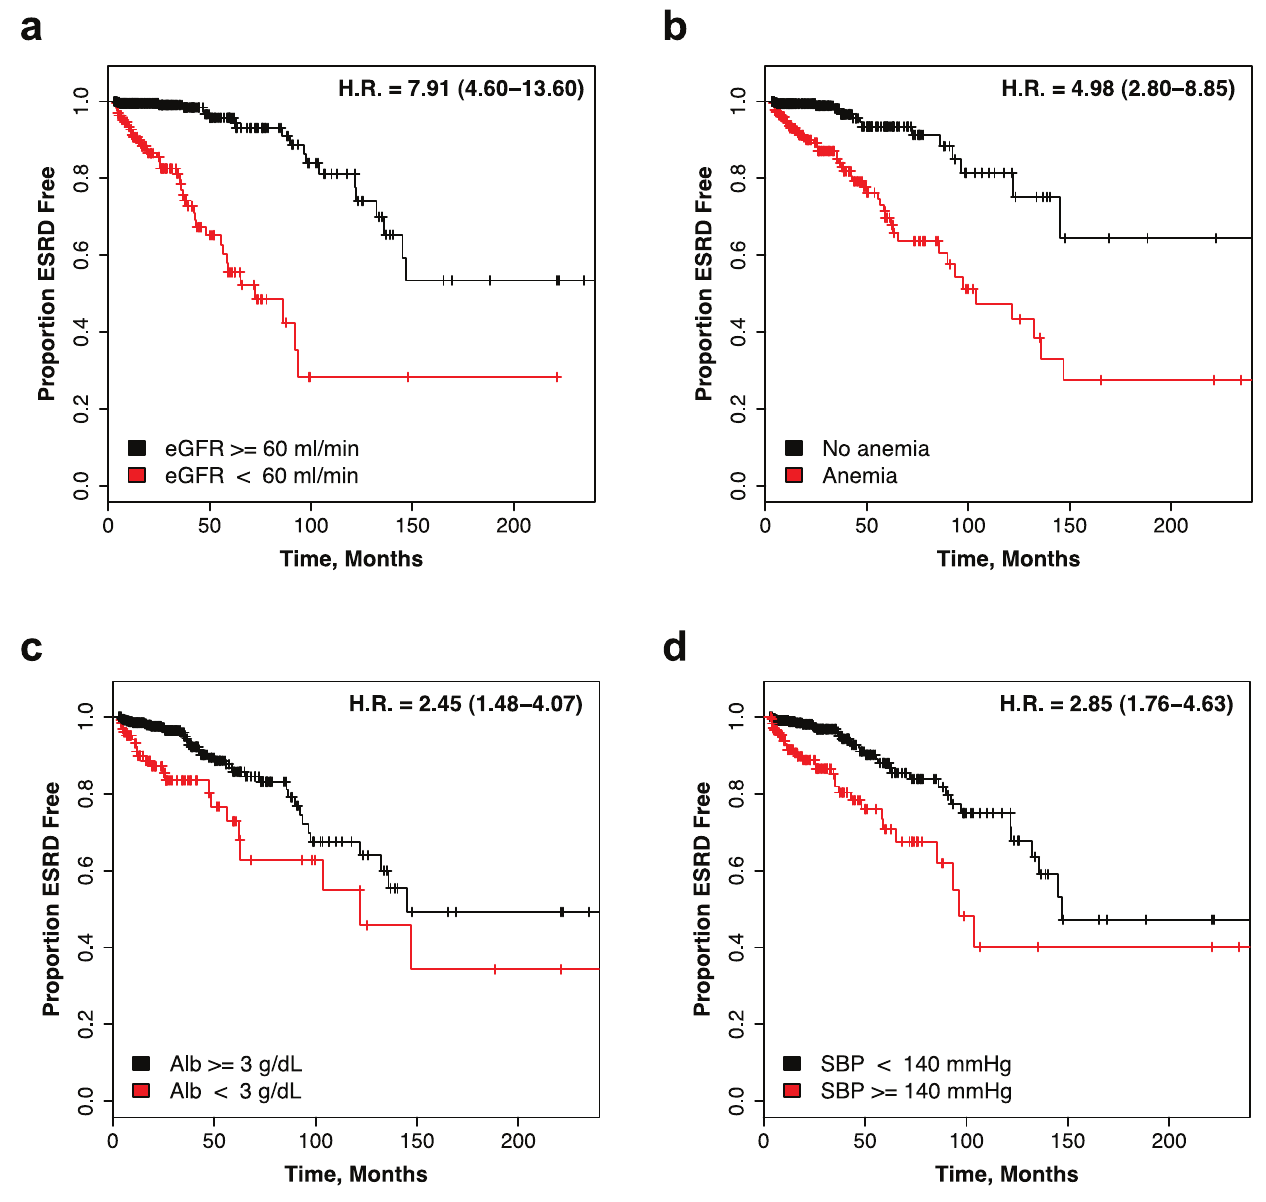
Figure 1. Kaplan-Meier Outcome-free Survival Curves. (a) low (red) versus high (black) baseline eGFR group; (b) patients with a baseline diagnosis of anemia (red) versus no anemia (black); (c) patients with hypoalbuminemia (red) versus normoalbuminemia (black); (d) patients with systolic hypertension (red) versus normotensives (black). Censor points are denoted by vertical tick lines.